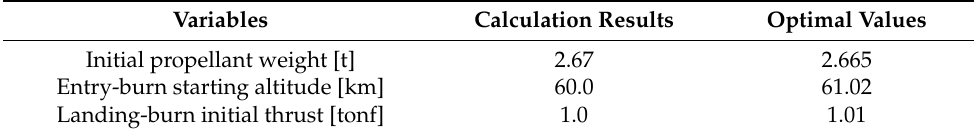
Table 10. Optimization results.